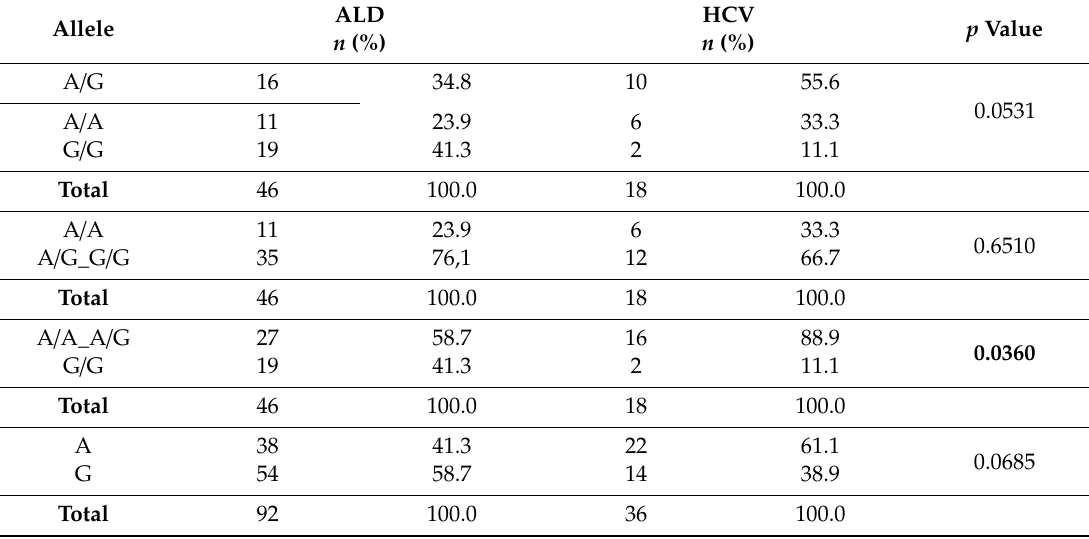
Table 4. Allele Frequencies Compared to Alcoholic liver disease (ALD) / hepatitis C virus (HCV) Groups—SNP rs6721961 (-178 A >